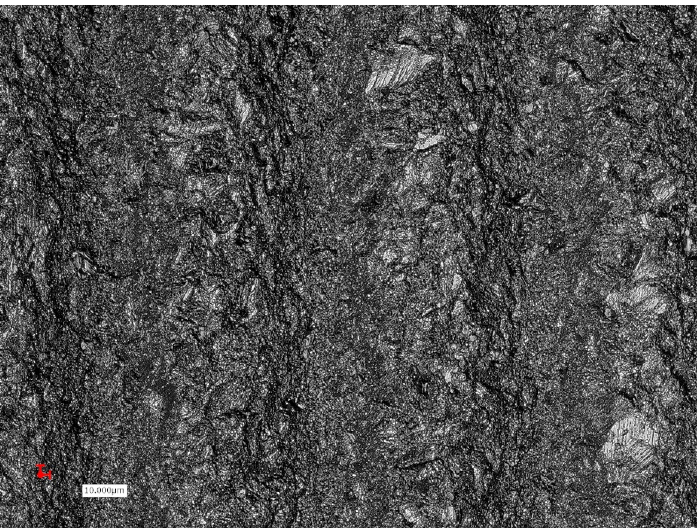
Figure 2. Sandblasted and acid-etched surface demonstrating changes of the implant roughness after implant insertion, and titanium particles detachment from the implant surface (lighter areas).